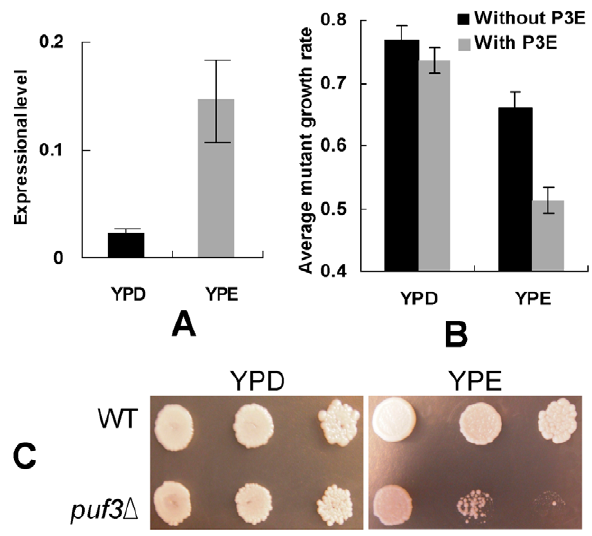
Figure 5. Function of the Puf3p regulon under different conditions. (A) The expression level of PUF3 gene in the fermentative (YPD) and respiratory (YPE) growth conditions. The ACT1 gene was used as a control in the real-time PCR experiments. (B) The average growth rate of gene deletion mutants for the mitochondrial genes with and without P3E in the two conditions. The student t-test was used to compare gene expression (in A) and average growth rate of gene deletion mutants (in B). (C) The growth of PUF3 gene deletion mutant and the wide-type (WT) strains in the two conditions.